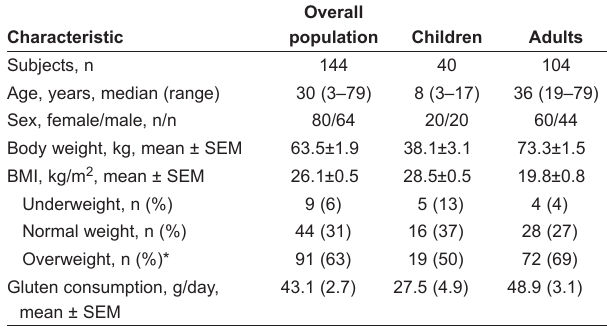
Table 1 Demographics, body mass index (bMI) and gluten consumption of the overall population and according